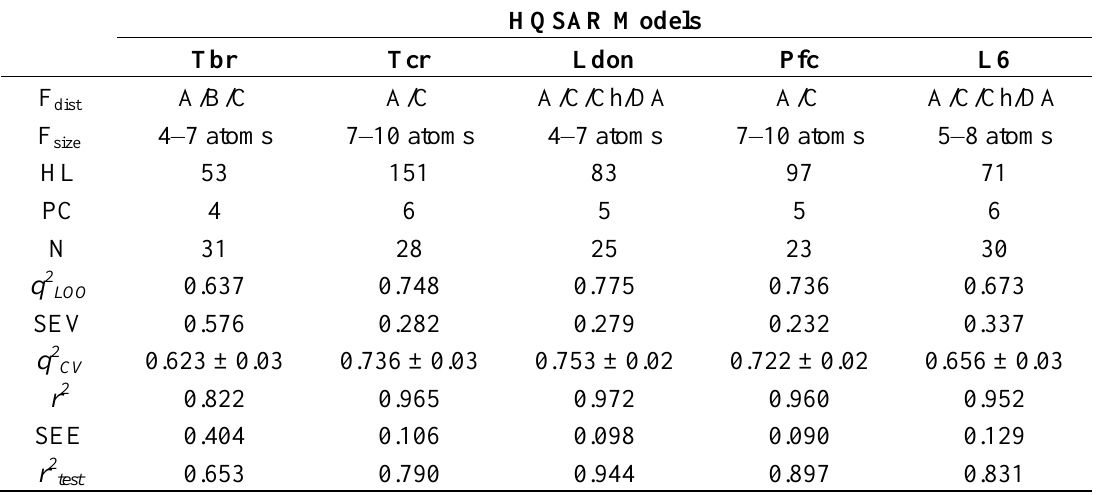
Table 3. Comparison of statistical results of all five constructed HQSAR models.